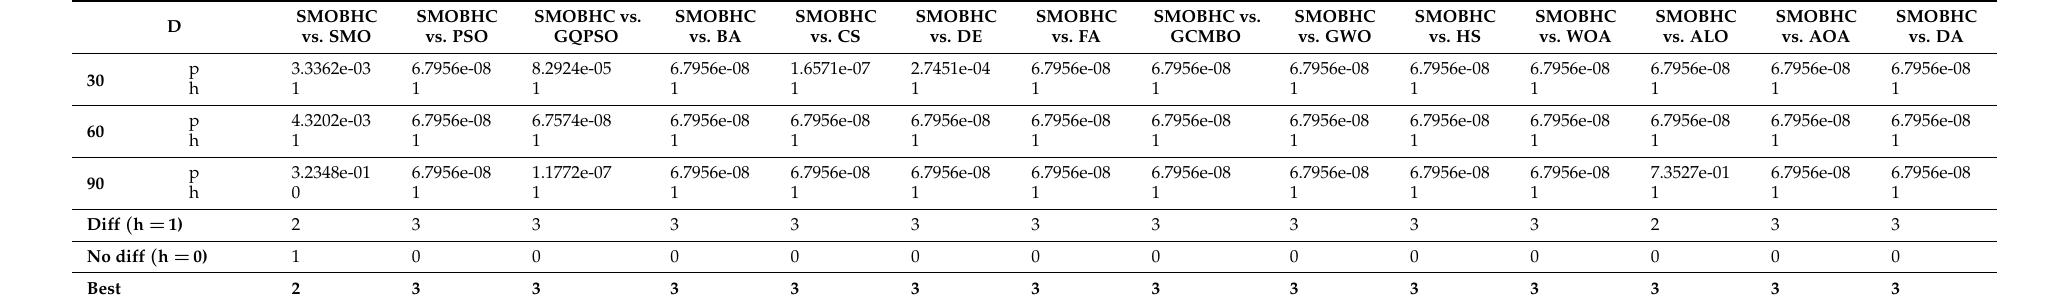
Table 4. Summarised Wilcoxon rank-sum comparisons between the SMOBHC algorithm as a reference and fourteen experimented algorithms for the first battlefield composed of ten